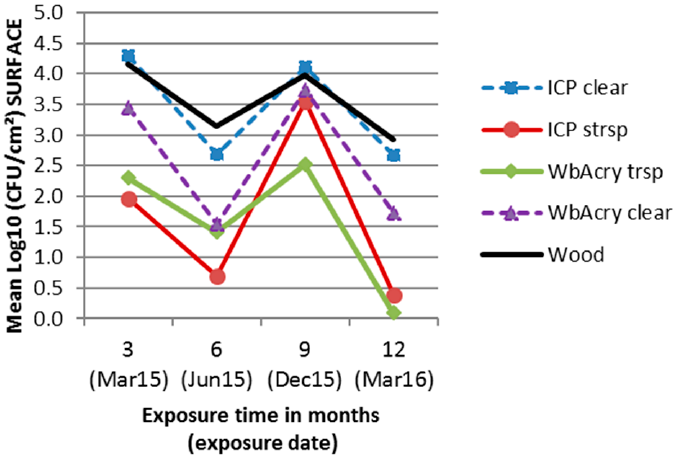
Figure 4. Surface fungal enumeration of panels versus exposure time.